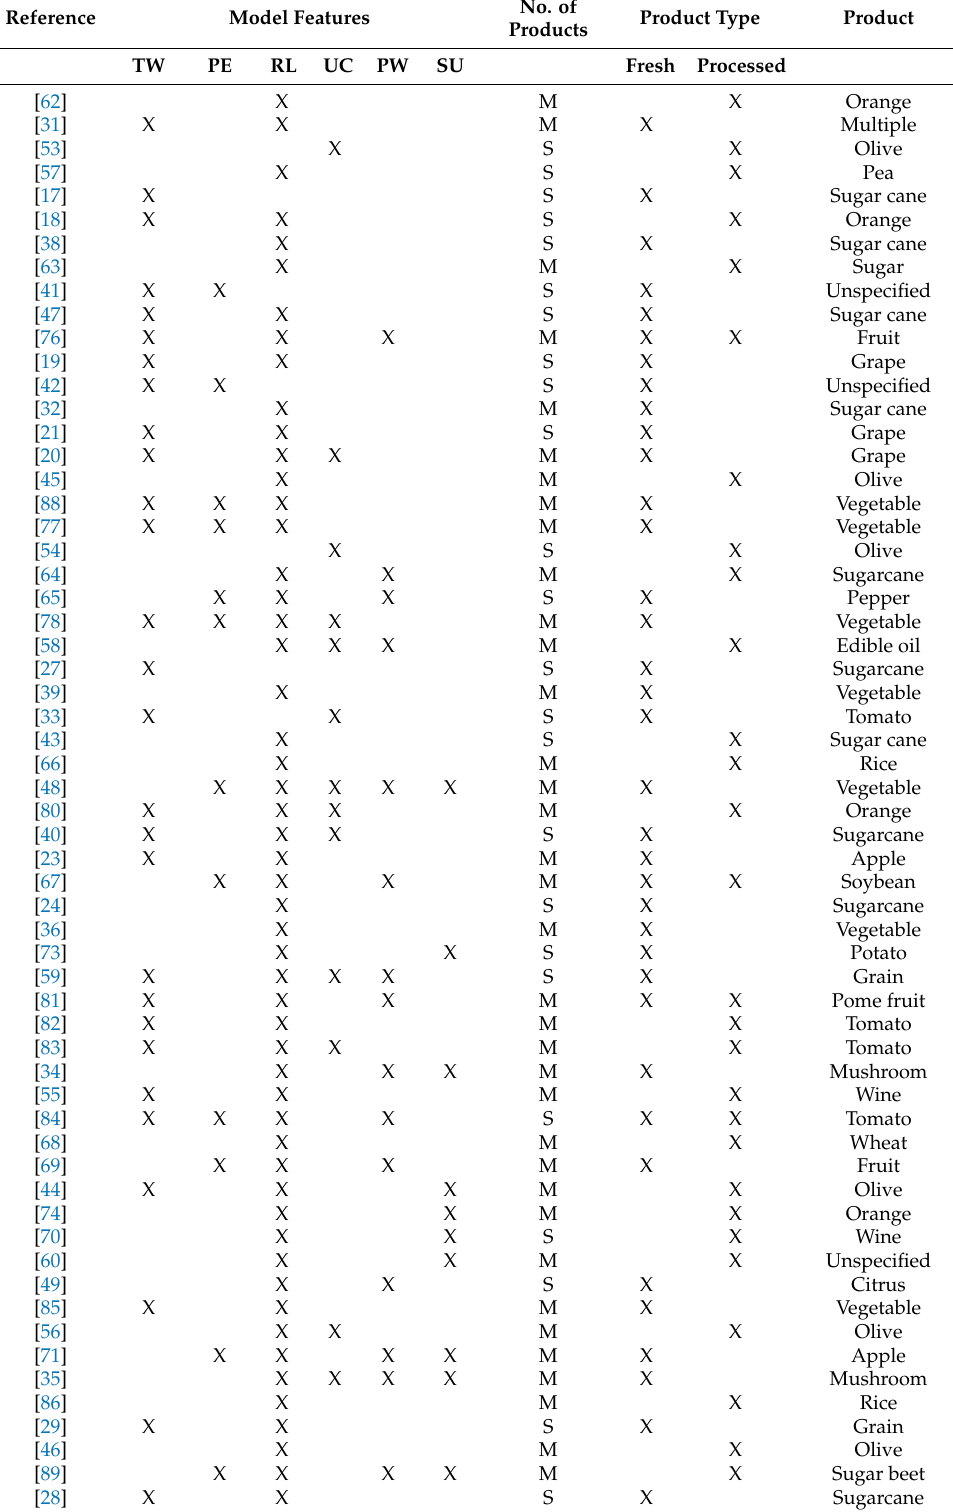
Table 3. Classification according to model